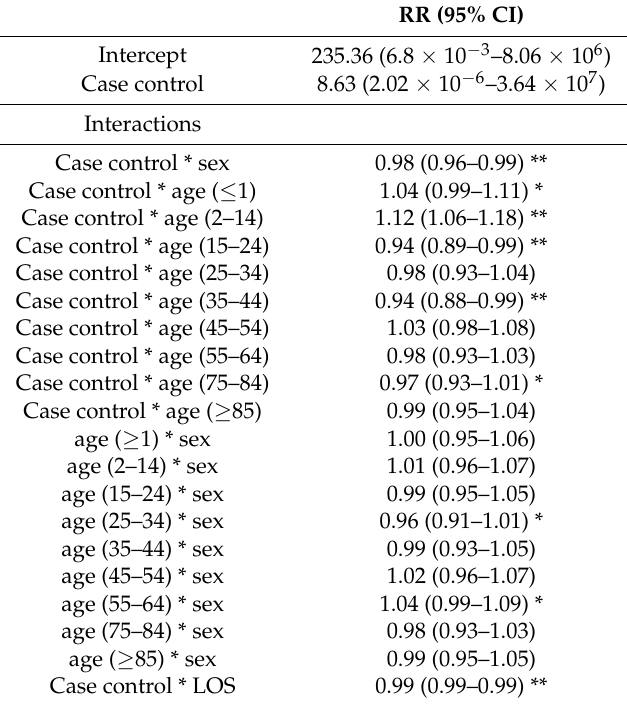
Table 4. Second case-control study (non-residents patients treated at Regional Public Hospitals vs. other types of